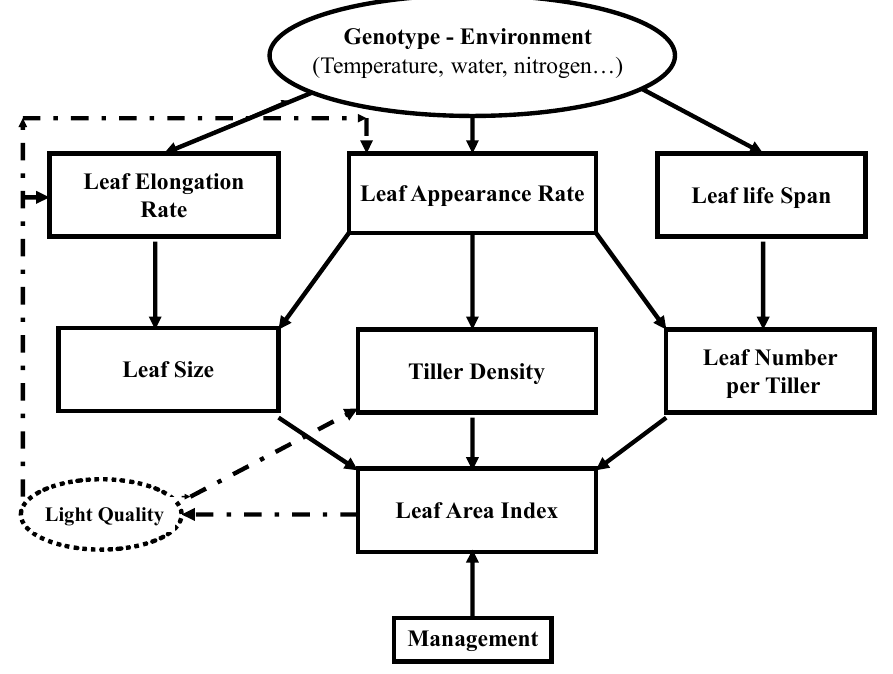
Figure 1. Determination of the grass sward structure in relation to components of shoot morphogenesis. Adapted from